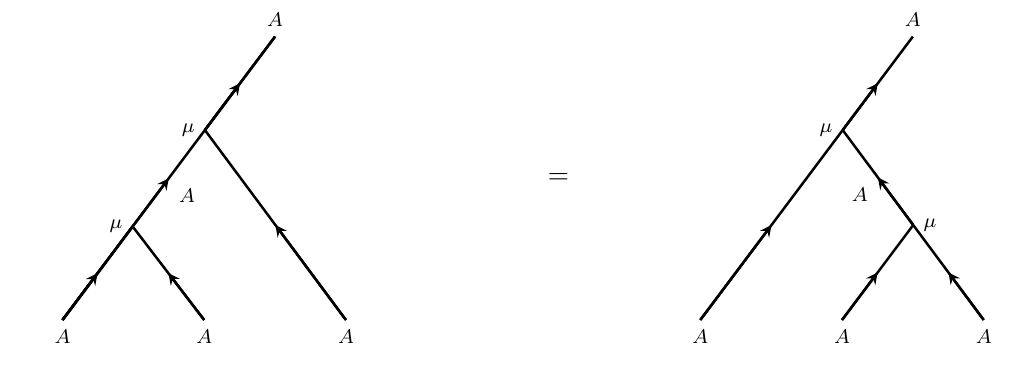
Figure 10 . Associativity axiom for an algebra object A 2 C .